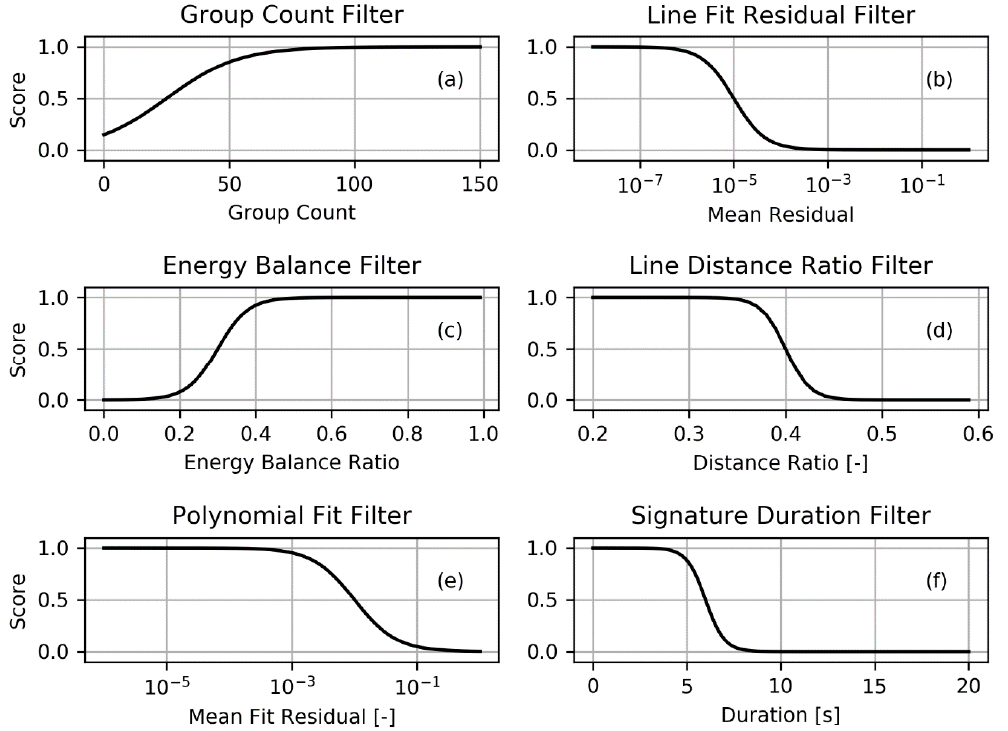
Figure 7. Filter functions providing the passing score in the range [0,1] for each test. A larger score is returned when: Plot ( a )—more groups constitute a flash; Plot ( b )—the line fit returns a low residual; Plot ( c )—the flash energy balance is skewed to later times; Plot ( d )—the maximum observed distance between any group and the fitted line is small; Plot ( e )—the polynomial fits return smaller residuals; Plot ( f )—the signature’s temporal duration is shorter.